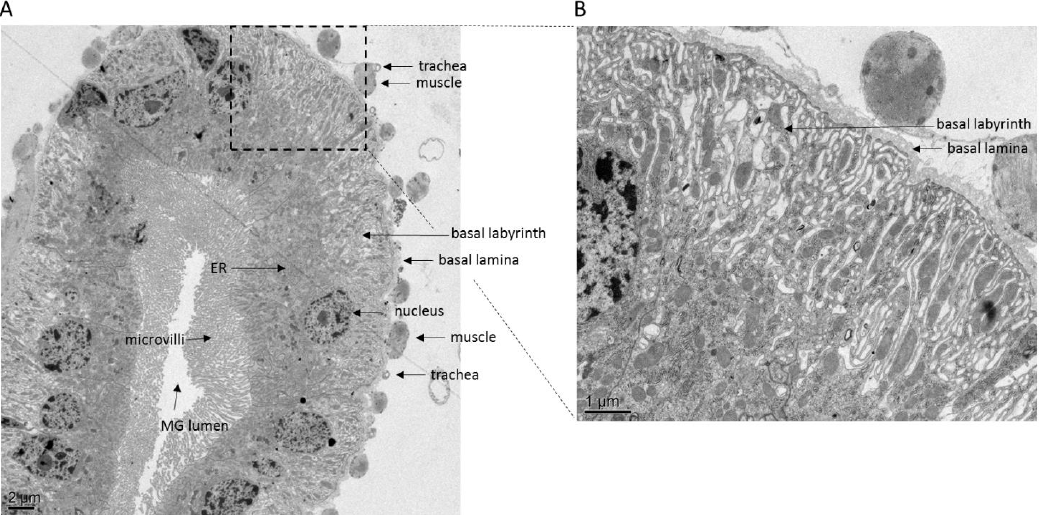
Figure 2. Ultrastructural views of the posterior midgut tissue of Ae. aegypti . ( A ) Cross-section of a non-infected midgut of a female at 7 days post-bloodmeal (magnification: 600×). ( B ) Close-up view of image in panel ( A ) at 2000× magnification. Note the structured BL surrounding the midgut. Dissected midguts were fixed in 2%